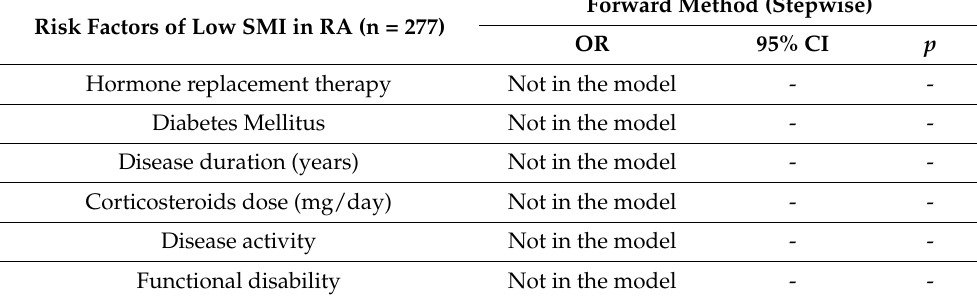
Table 3. Cont. Forward Method (Stepwise) Risk Factors of Low SMI in RA (n = 277) OR 95% CI p Hormone replacement therapy Not in the model - - Diabetes Mellitus Not in the model - - Disease duration (years) Not in the model - - Corticosteroids dose (mg/day) Not in the model - - Disease activity Not in the model - - Functional disability Not in the model -